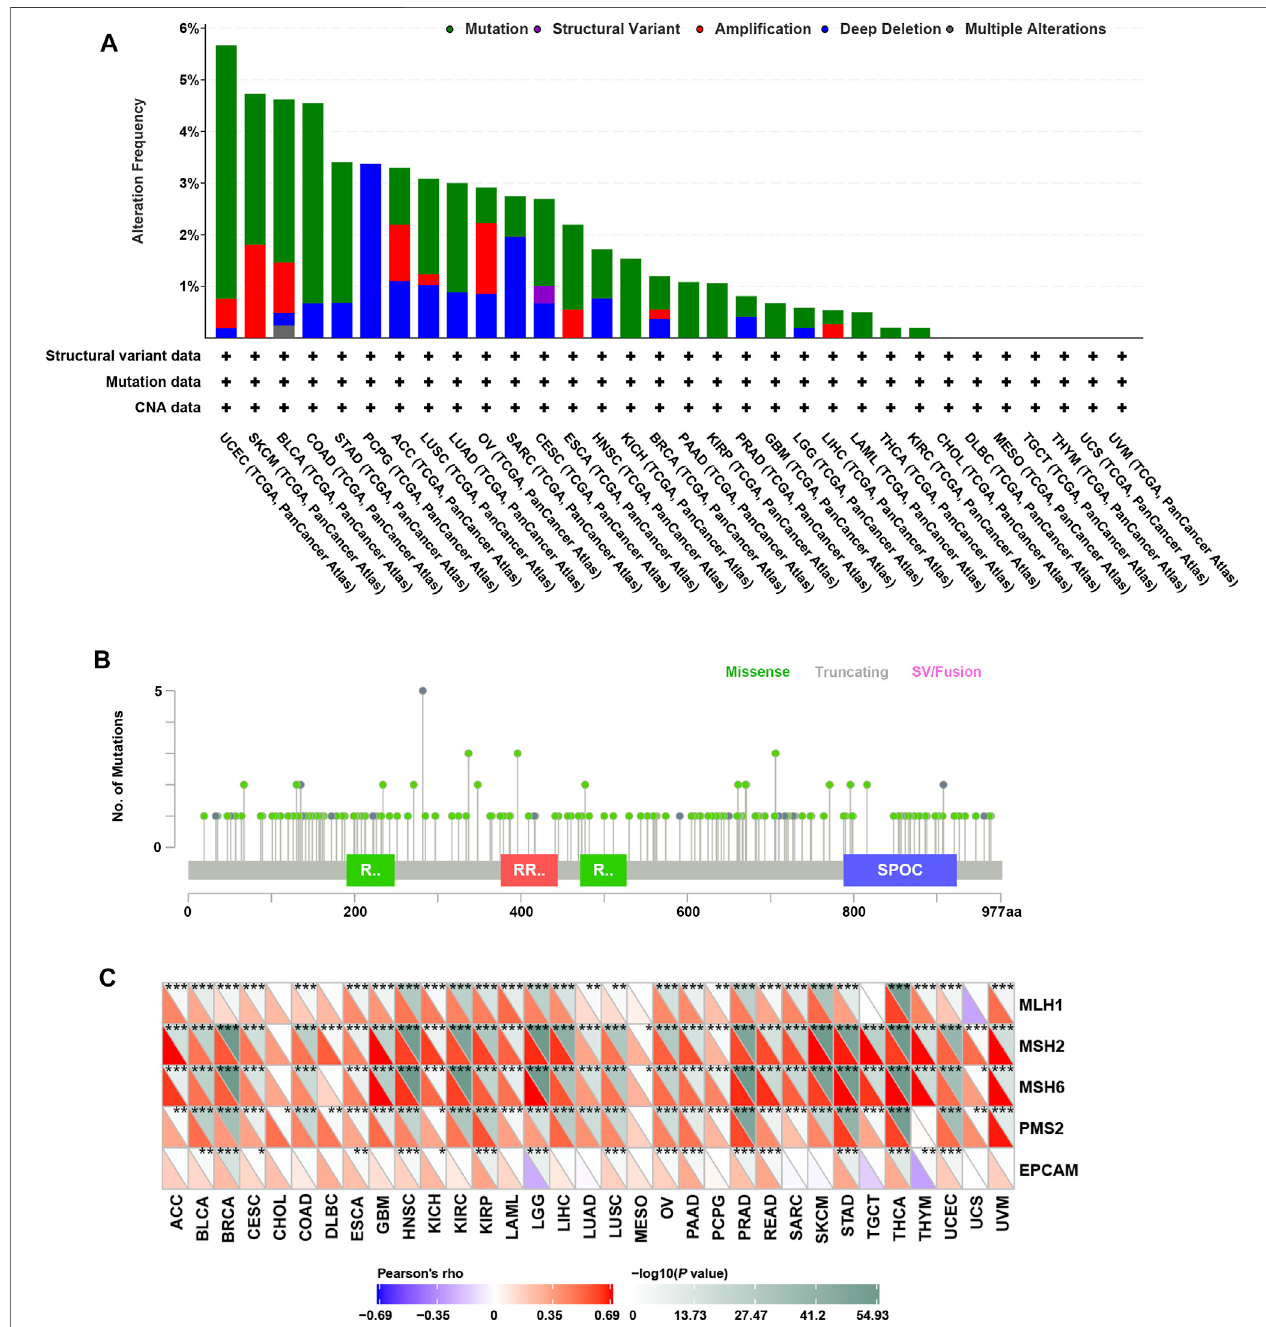
FIGURE1| GenomicalterationsofRBM15inhumanpan-cancer. (A) ThealterationfrequencyofRBM15acrosstumors. (B) ThetypesanddistributionsofRBM15 mutations. X-axis, amino acid; Y-axis, numbers of RBM15 mutations; green/red box, RNA recognition motif (190-248aa, 376-444aa, 471-527aa); blue box, SPOC domain (788-924aa). (C) Correlation of RBM15 expression with four MMR genes mutation.